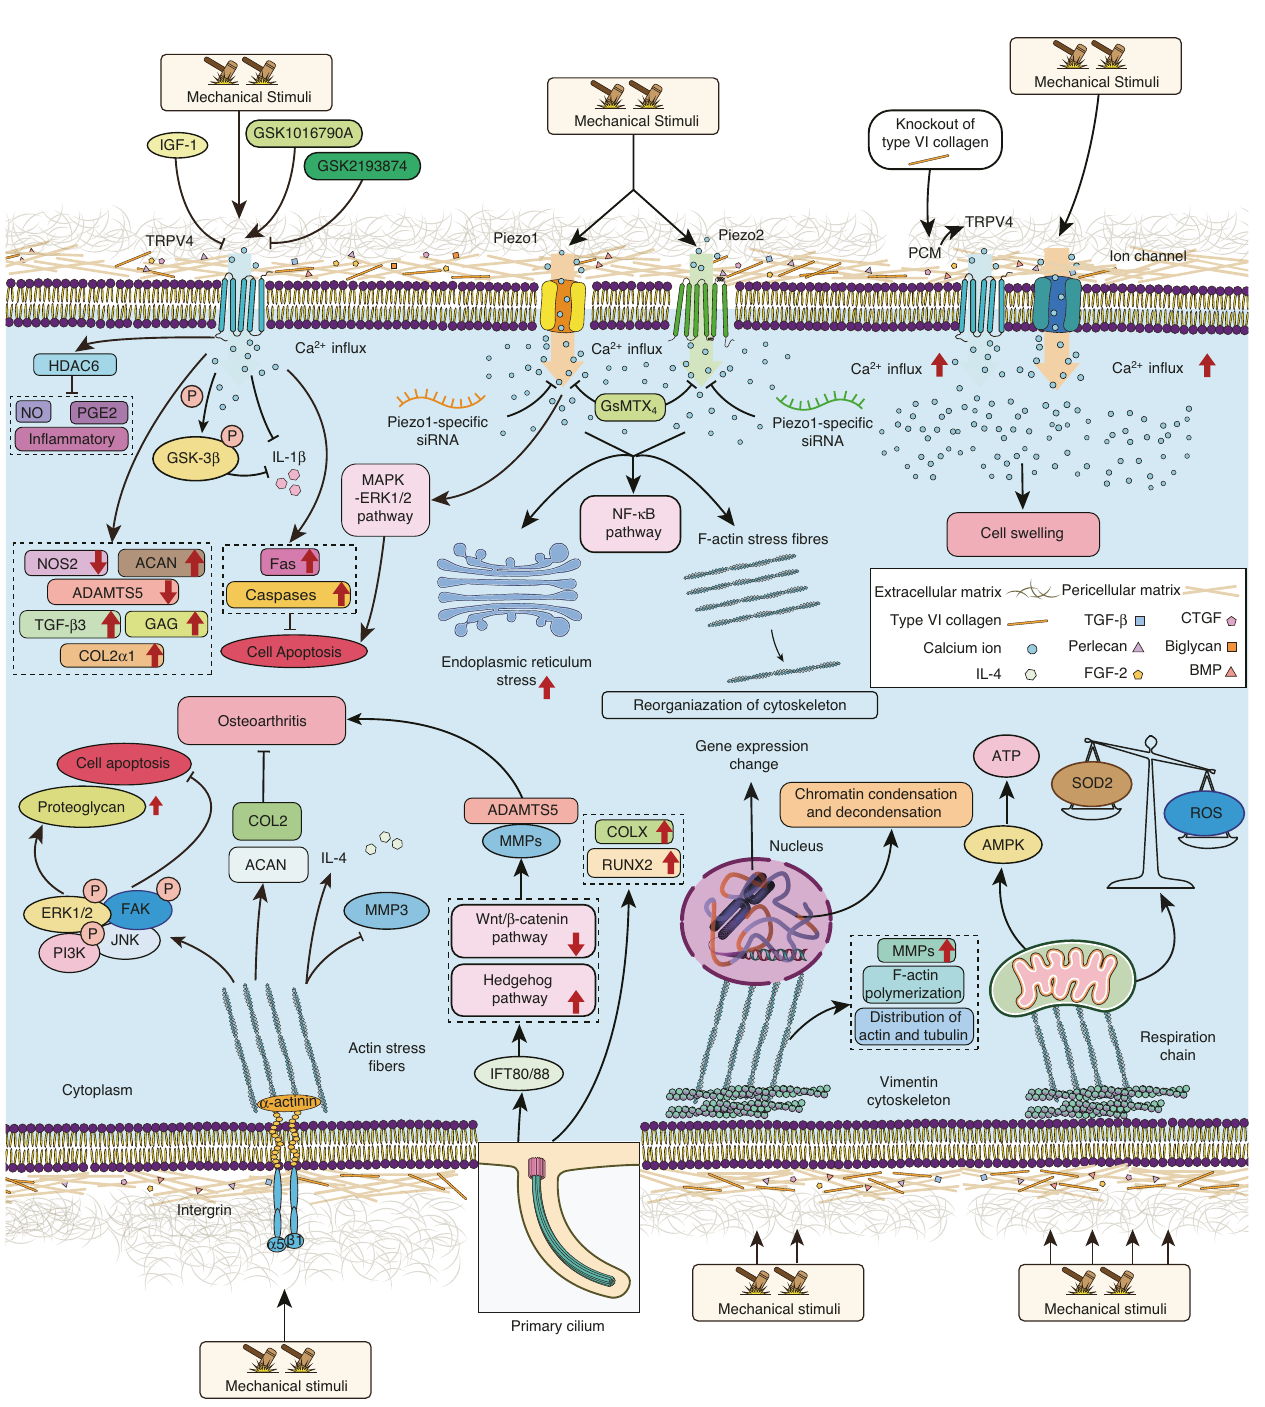
Fig. 2 Different mechanosensors and their downstream pathways in articular chondrocytes. Pointed arrows indicate stimulatory effects, whereas blocked lines indicate inhibitory effects. IGF-1: insulin-like growth factor-1, TRPV4: transient receptor potential channel subfamily V member 4, GSK1016790A: TRPV4 agonist, GSK2193874: TRPV4 antagonist, GSK-3 β : glycogen synthase kinase 3beta, HDAC6: histone deacetylase 6, PGE2: prostaglandin E2, NOS2: nitric oxide synthase, ACAN: aggrecan, ADAMT: a disintegrin and metalloproteinase with thrombospondin motifs, TGF- β : transforming growth factor-beta, GAG: glycosaminoglycan, IL: interleukin, NO: nitric oxide, COL2: type II collagen, GsMTX4: selective Piezo-inhibiting peptide, NF- κ B: nuclear factor κ B, F-actin: fi lamentous actin, MAPK: mitogen-activated protein kinase, ERK: extracellular signal-regulated kinase, PCM: pericellular matrix, CTGF: connective tissue growth factor, FGF: fi broblast growth factor, BMP: bone morphogenic protein, FAK: focal adhesion kinase, PI3K: phosphatidylinositol 3-kinase, JNK: c-Jun amino-terminal kinase, MMP: matrix metalloproteinase, IFT80/88: intra fl agellar transport 80/88, COLX: type X collagen, RUNX2: Runt-related transcription factor 2, and AMPK: AMP-activated protein